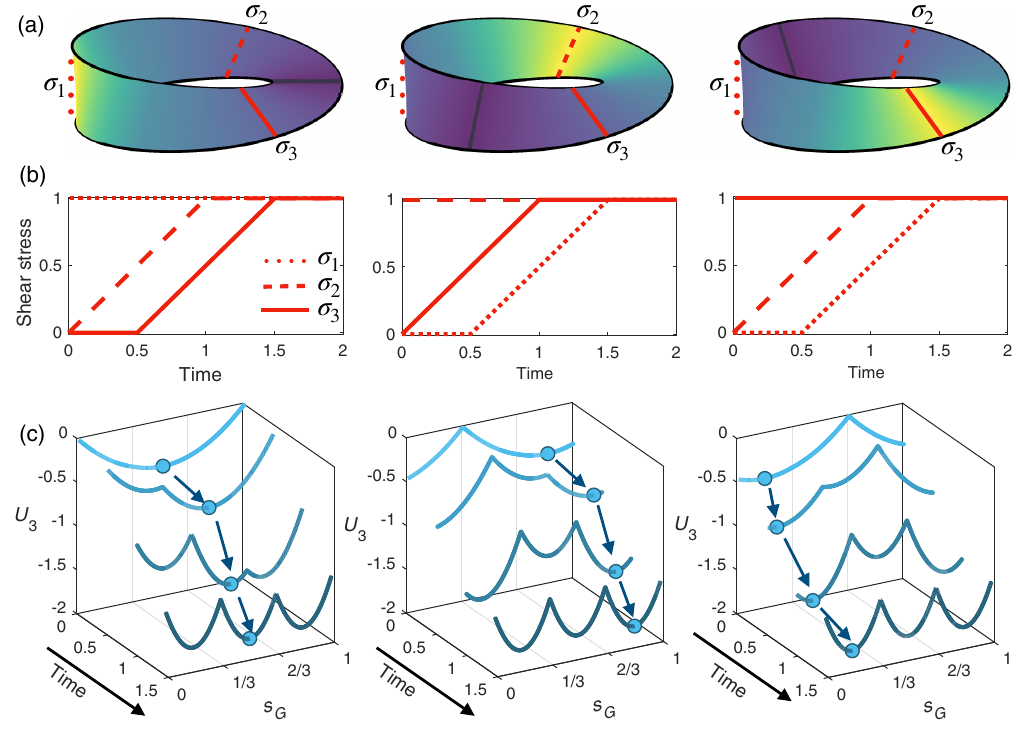
FIG. 5. Elastic memory. (a) Three different shear deformations are compatible with mechanical equilibrium when pointwise shear stresses of equal strength K are applied at s ¼ 1 = 6 ; 1 = 2 , and 5 = 6 . The colors indicate the magnitude of the shear deformations θ S ; same color map as in Fig. 3. (b) Corresponding time variations of the stress amplitude. (c) Spatial and temporal variations of the effective potential U 3 ð s; t Þ . The blue circle indicates the location of the instantaneous minimum of U 3 where s G is